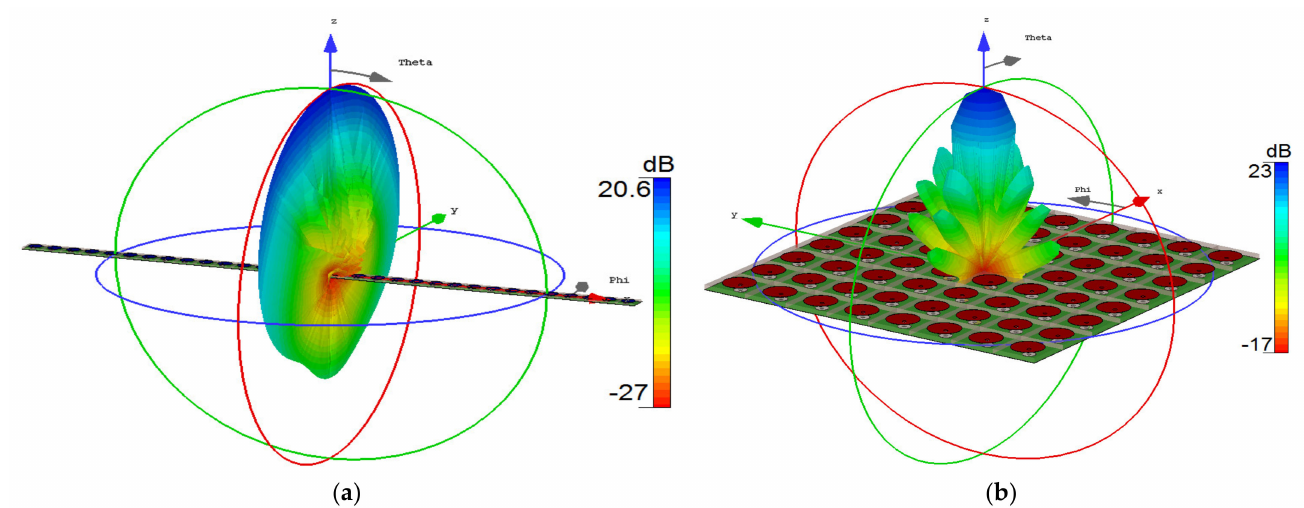
Figure 5. The proposed array’s 3D design and main radiation beams: ( a ) 1 × 32 Linear array; ( b ) 8 × 8 planar array.